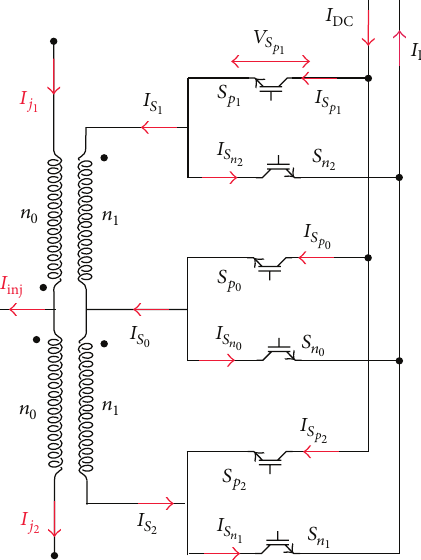
Figure 5: Reinjection current flow for a 3-level MLCR